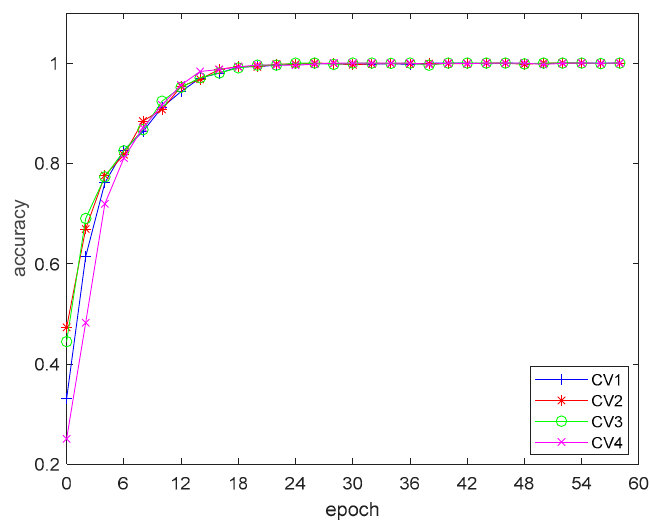
Figure 10. Training accuracy during cross-training.